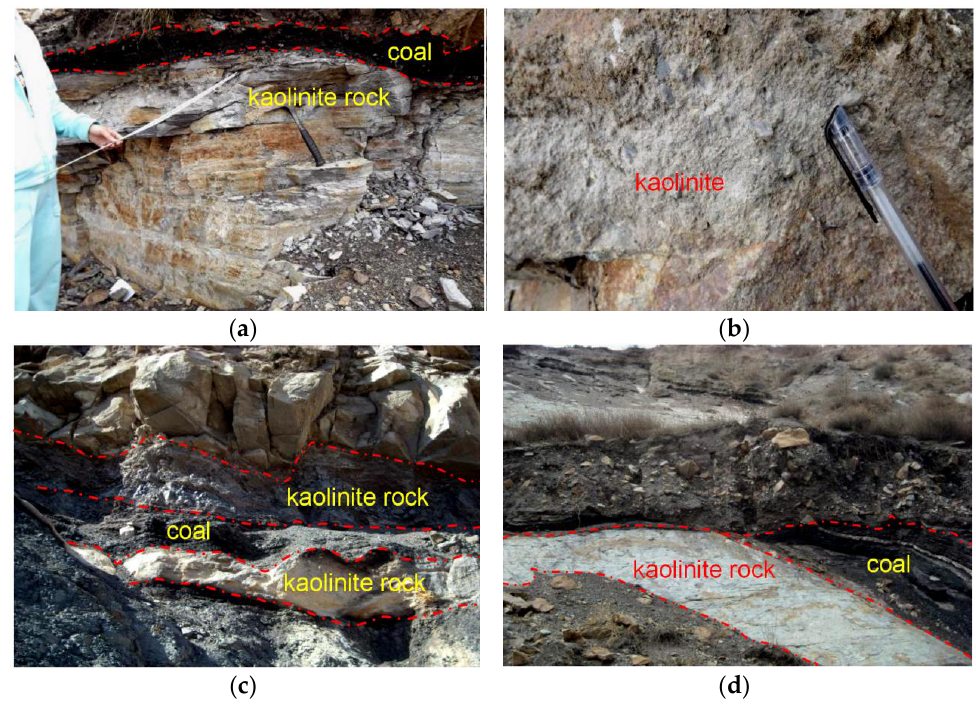
Figure 2. The kaolinite rocks field outcrop in Datong coalfield: ( a ) represents the S4F kaolinite rock, ( b ) the kaolinite in C2F, ( c ) represents the C3R and ( d ) represents C8F.